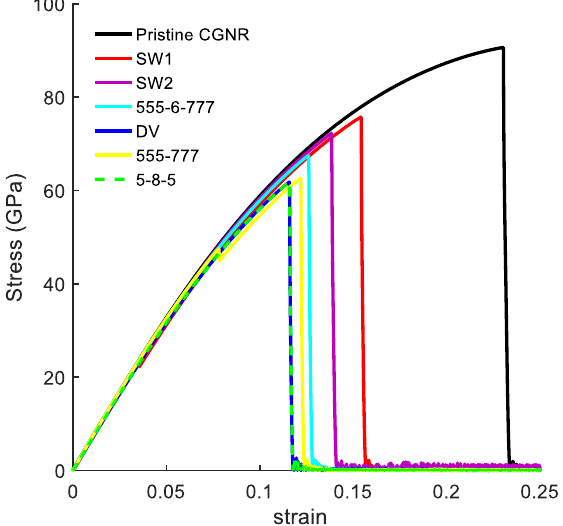
Figure 9. Stress–strain curves for the defects: DV, 5-8-5, 555-777, 5555-6-7777, SW1, and SW2 defects. Nanomaterials 2020 , 10 , x FOR PEER REVIEW